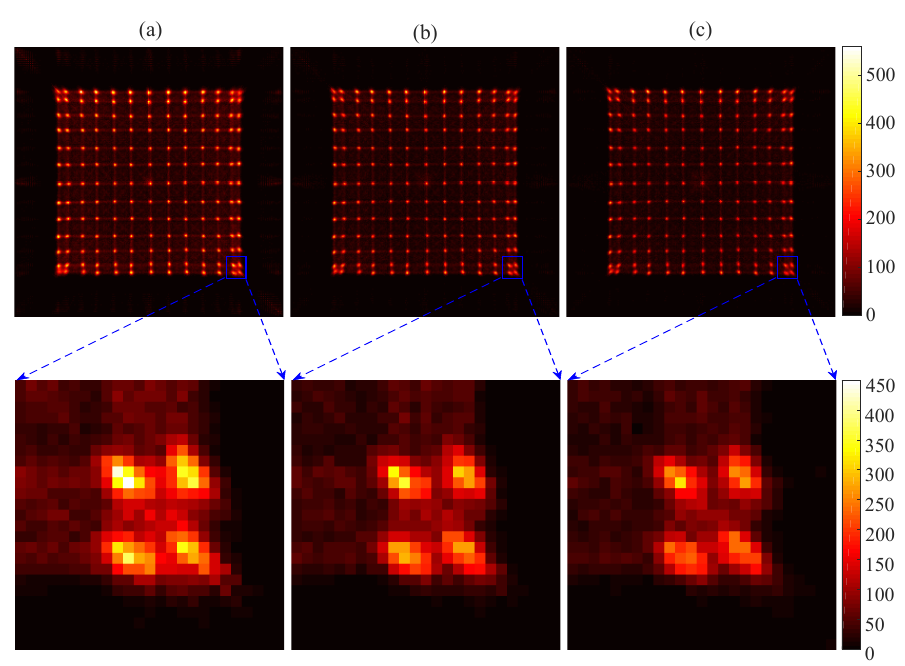
Figure 13. The flood histograms obtained with ADC overflow ratios of 5% ( a ), 30% ( b ), and 60% ( c ). The four spots at the edge of the flood histogram are given to observe the differences of the